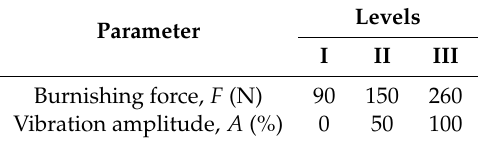
Table 2. Parameters considered in the experimental design and their values.